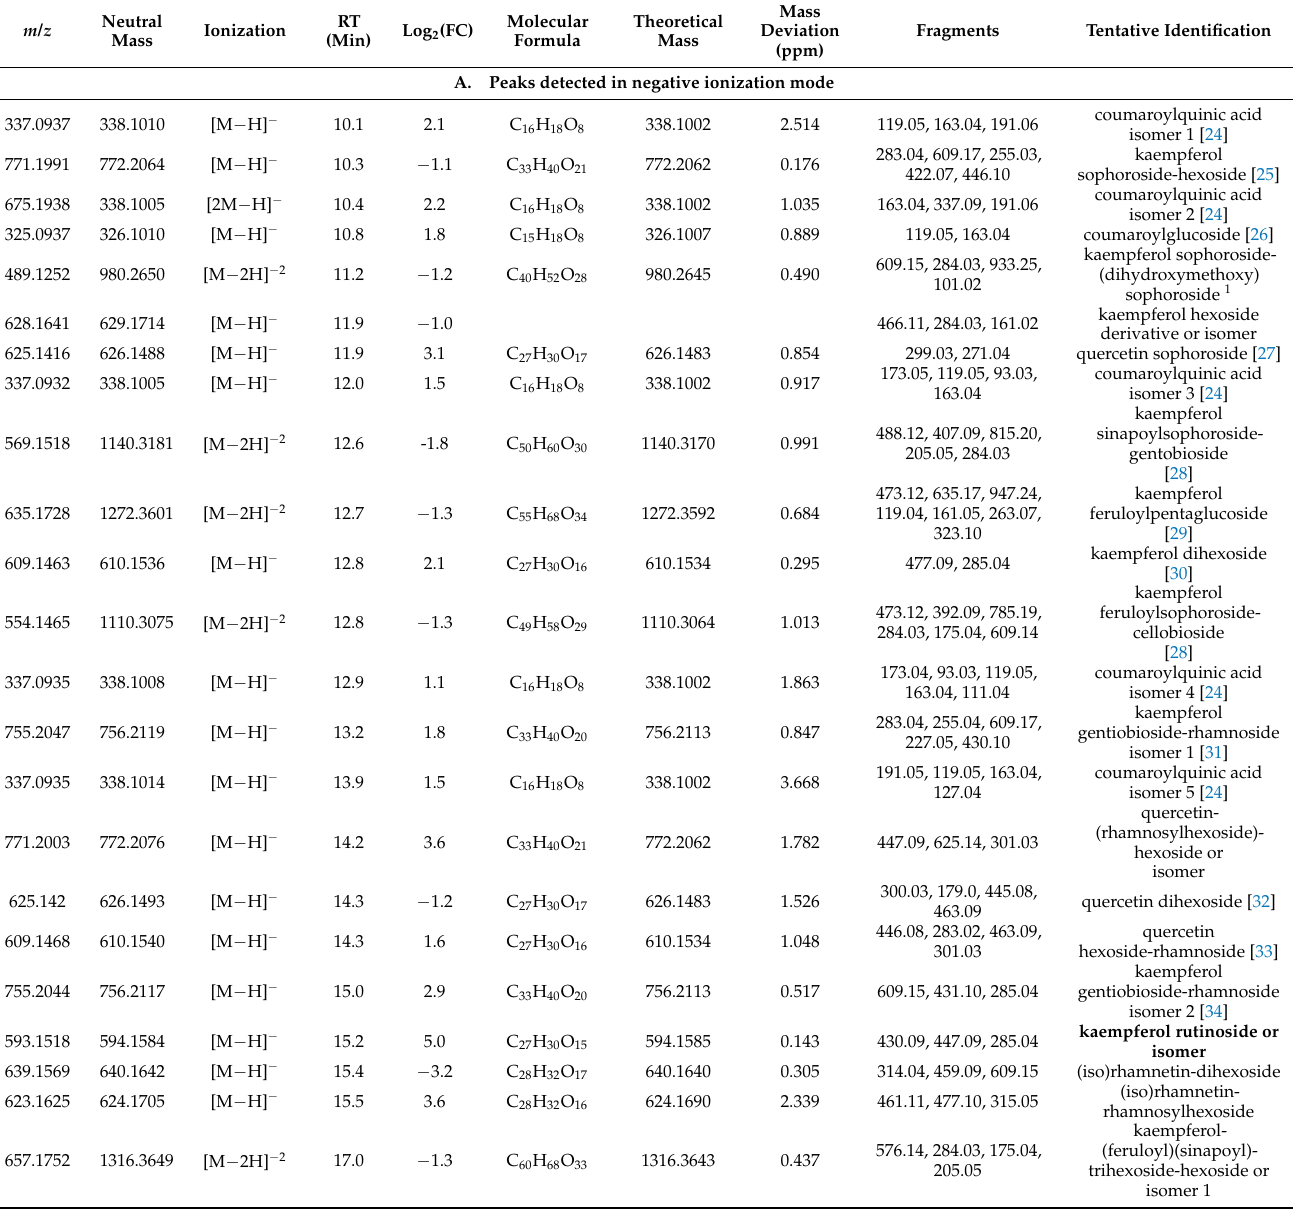
Table 1. Tentative identification of metabolites with a | log 2 ( FC ) | ≥ 1 and statistically significant difference (FDR ≤ 0.05) between populations (High-Indol-3-ylmethylGSL vs. Low-Indol-3-ylmethylGSL content). Metabolites are sorted by ionization mode. References to the identification of compounds in the Brassicaceae plant family is included when available. Compounds in bold: fragmentation spectra match with authentic standard. Underlined compounds: retention time match with authentic